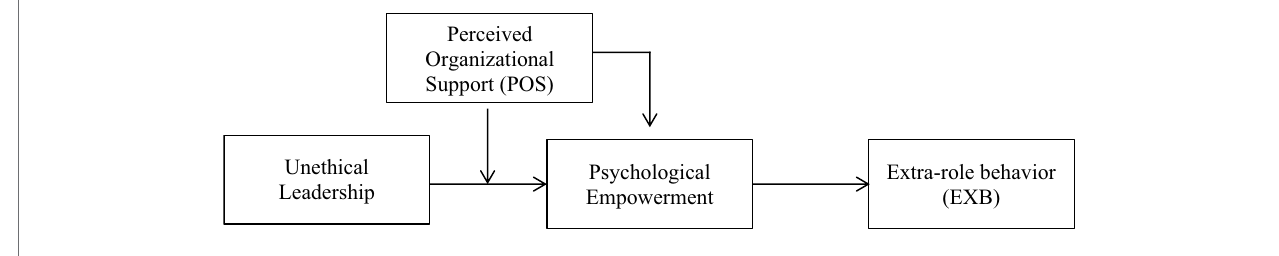
FIGURE 1 | Research